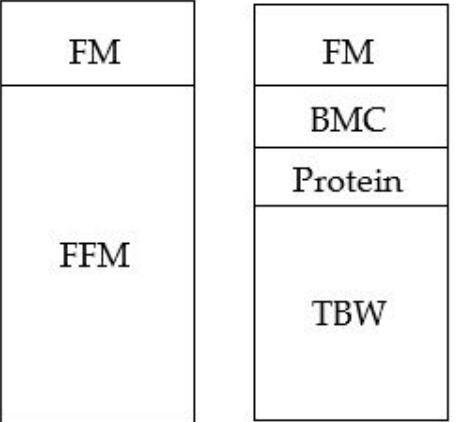
Figure 1. Components of a two-compartment and a four-compartment model of body